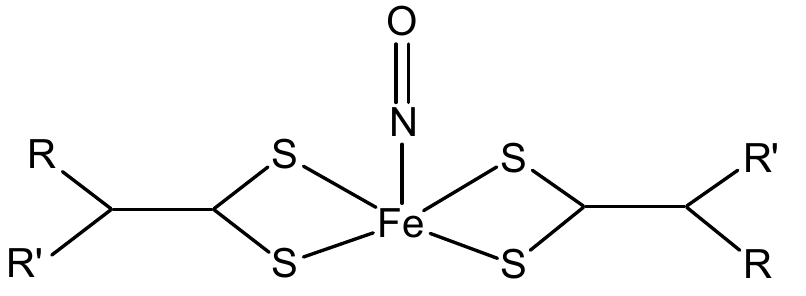
Figure 9. Structure of the complex Fe(MGD) 2 (NO).